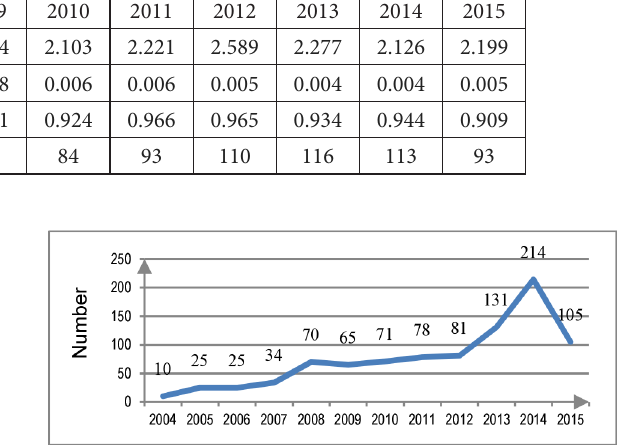
Figure 7. The number of patents developed by enterprise- university from 2004 to 2015